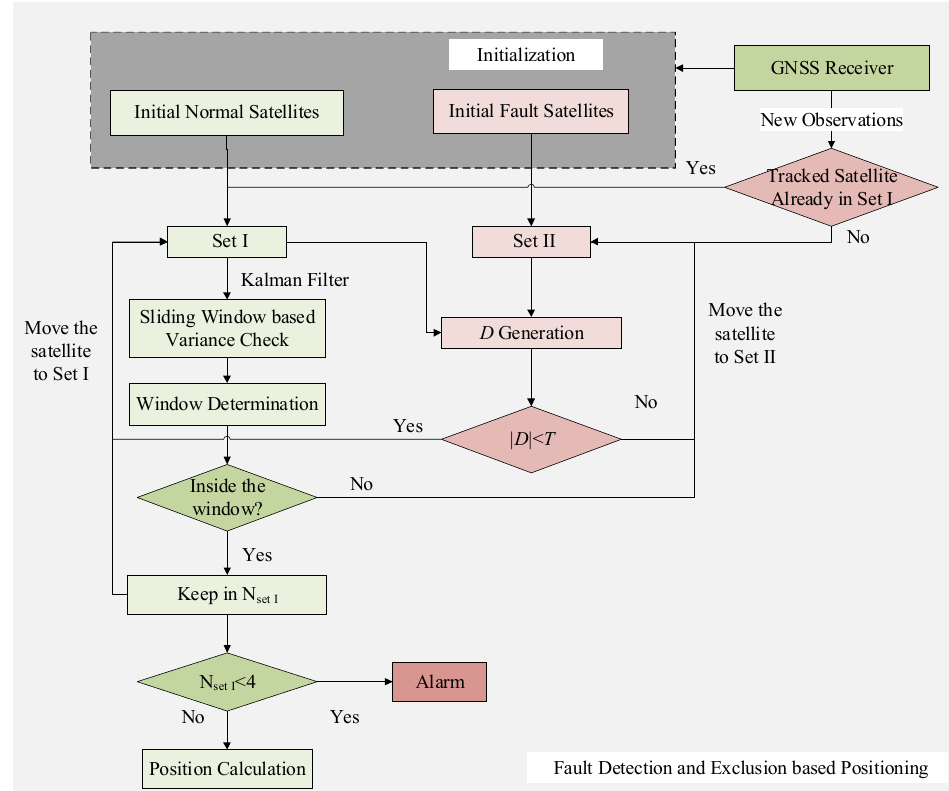
Figure 2. System framework.